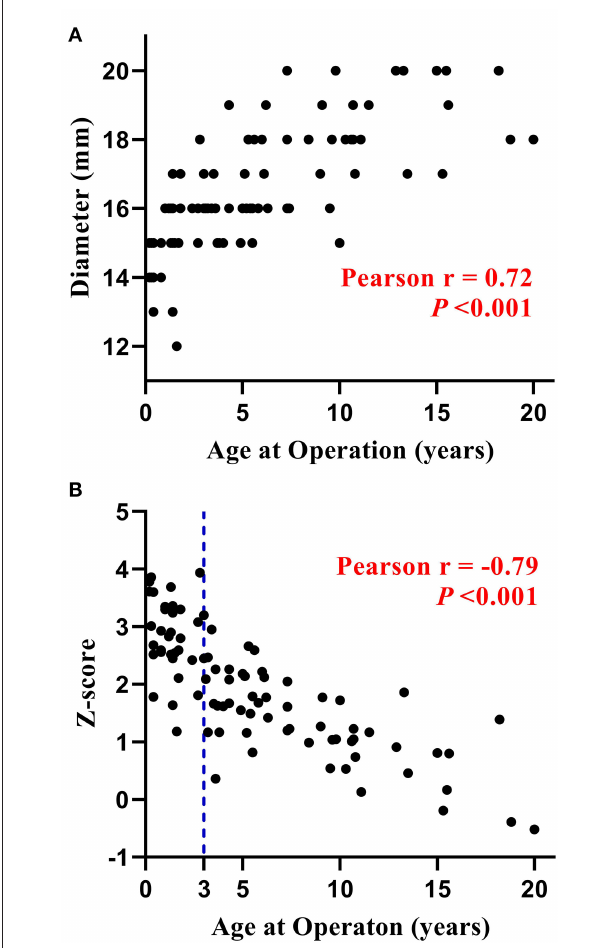
FIGURE 1 | Distribution of the diameter (A) and z-score (B) of DP-BJVC at implantation. The conduit diameter (range from 12 to 20mm) is significant positive corrected with patients’ age ( P < 0.001), while the conduit z-score is significant negative corrected with patients’ age ( P < 0.001). Particularly, four patients ≤ 3 years, as well as most of the older patients, received a conduit with z-score < +